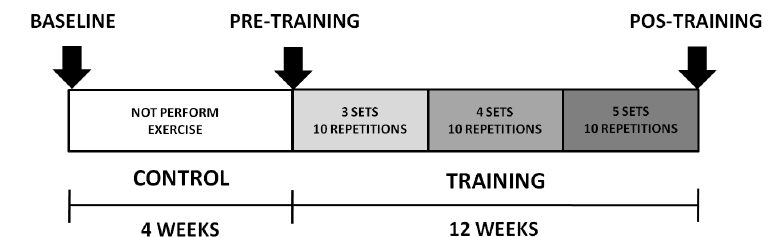
Figure 1. Experimental design of the study: a control period during four weeks; a 12-week isokinetic eccentric training period; and three evaluation sessions (indicated by the arrows) throughout the study.